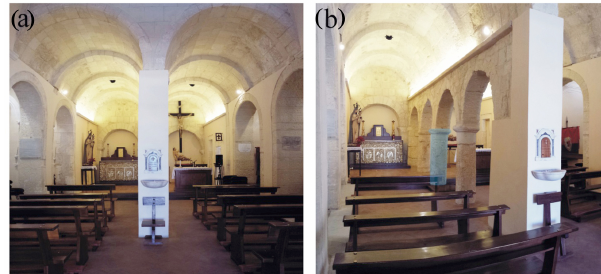
Figure 2. The interior of the church of Saints Lorenzo and Pancra- tio: (a) the two barrel vaulted naves; (b) the columns that support the round arches (the investigated column is highlighted in light